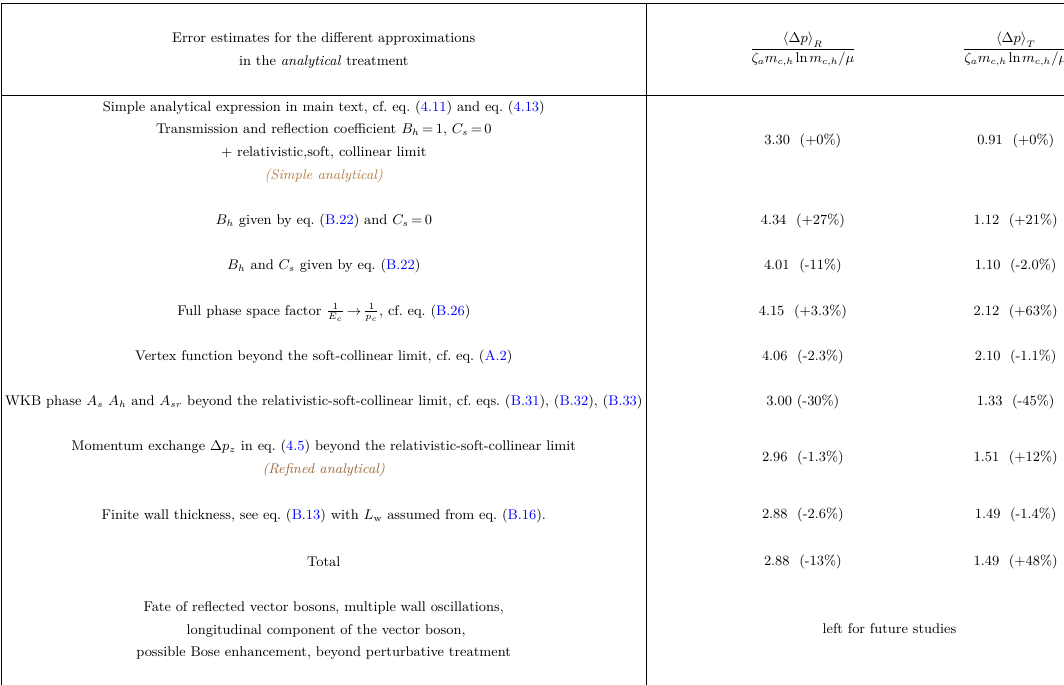
Table 2 . In the table above, we refine the simplest analytical estimate, line after line from top to bottom until we obtain the most refined one. The percents % show the relative differences between two consecutive lines, except for the ones on the line entitled ‘total’ which shows the relative difference between the simplest and the most refined estimates. The relative difference between the analytical and numerical treatment can be appreciated in figure 12. The values of the present table were evaluated for µ = 10 − 4 m c,h and h φ i = TeV as well as the same values of the parameters as in figure 12. Corrections due to the presence of reflected bosons in front of the wall, see section 6, due to multiple wall oscillations, see footnote 11, due to the longitudinal vector boson, see footnote 3, due to Bose enhancement, see footnote 2, and due to non-perturbative effects, see section 3.4, are left for further